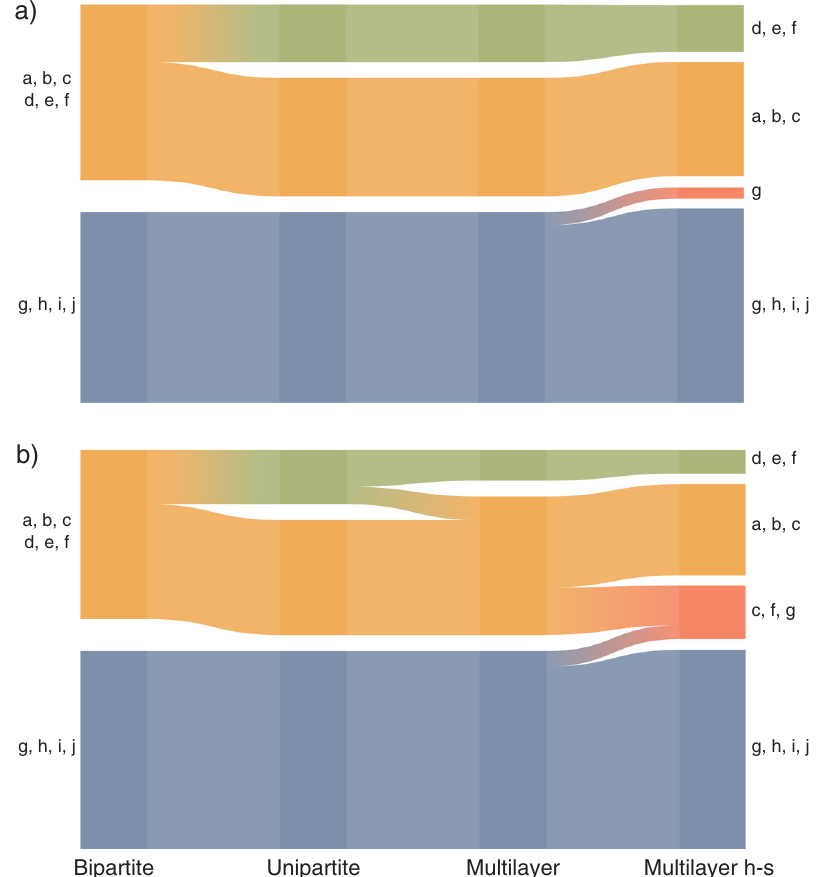
Fig. 3 Alluvial diagrams of optimal partitions for the schematic hypergraph in Fig. 1a. Darker bars represent the optimised modules in each partition, with height proportional to the fl ow volume of the contained nodes a to j . Streamlines connect modules that contain the same node(s). a Optimal partitions for lazy walks represented with the networks in Fig. 1b – d using the same colours. b Optimal partitions for non-lazy walks. The non-lazy bipartite representation with the same colours as in Fig. 2. h-s